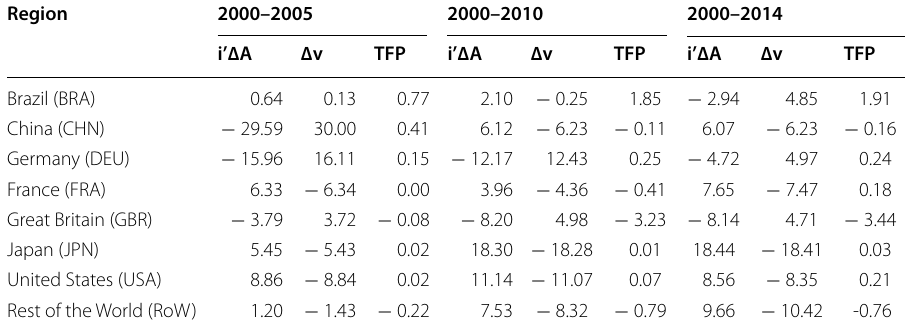
Source: research